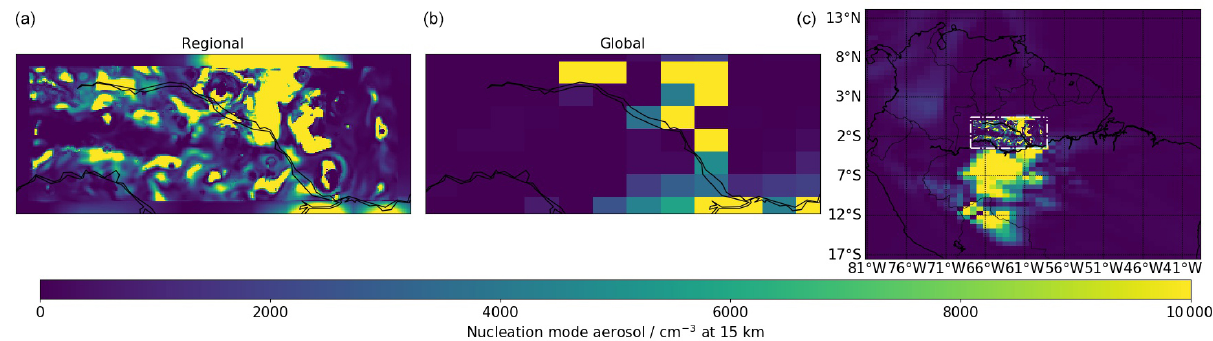
Figure 2. Maps of nucleation mode aerosol number concentrations from the regional (a) and global models (b) at a height of 15km and at 15:00UTC on 17 September 2014. The map on the right presents a broader view of South America and shows the location of the regional domain (dotted dashed box).